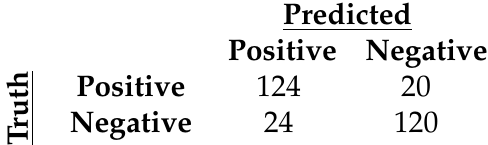
Figure 27. FeatSpaceEnsNet 2 confusion